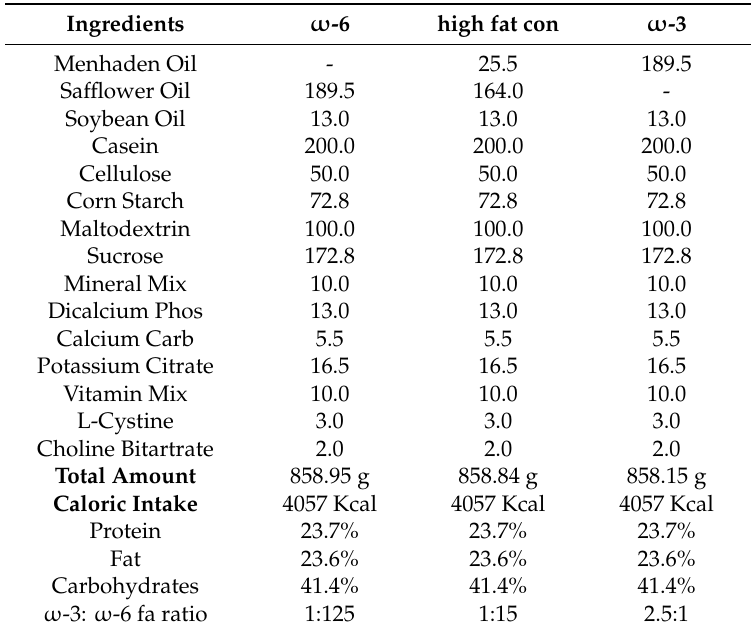
Table 1. Composition of high-fat diets. Mice were fed one of three high-fat diets with the same total kcal content, 45% of which came from fat. The control diet (high-fat con) had an ω 3 to ω 6 ratio of 1:15, mimicking that found in a standard mouse chow. The ω 3 diet had an increased ω 3 to ω 6 ratio (2.5:1), while the ω 6 diet had a decreased ratio of